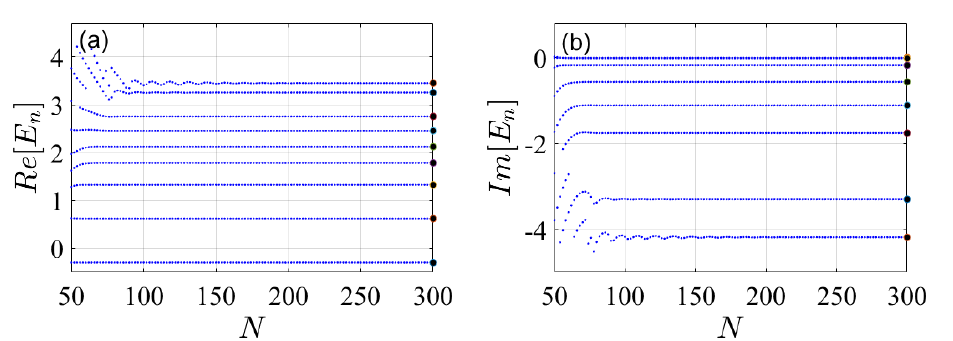
Figure 6. Stabilization graph of the complex scaled spectrum { E n = ε n − i Γ n /2 } as obtained by the present FDM. ( a ) Real part and ( b ) imaginary part of the spectrum. The grid points were rotated to the complex coordinate plane by an angle θ = 0.5, leading to { x i → x i exp ( i θ ) } i = 1,2,..., N . Exact values of the energies and widths are presented by large black circles on the right hand side.